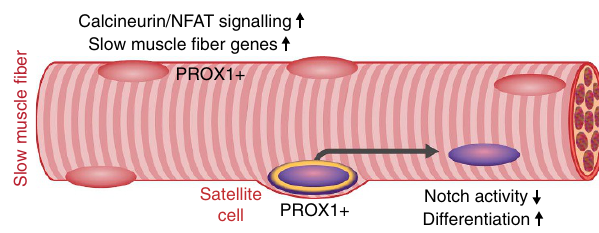
Figure 8 | Schematic summary of the pathways regulated by Prox1 in mature skeletal muscle fibres and satellite cells. Prox1 is expressed in mature slow muscle fibres, where it regulates NFAT signalling and muscle fibre type gene programs. Prox1 is also expressed in satellite cells, where it interacts with Notch signalling pathway, and it is essential for